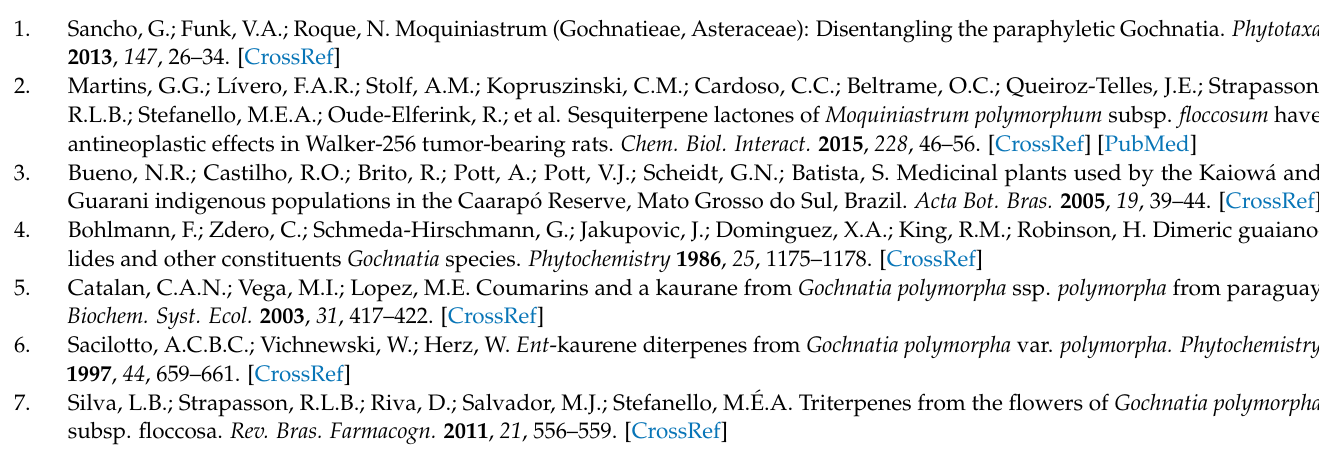
Figure S2: Feature-based molecular network of the 18 extracts from OSMAC approach. Each cluster is formed by interconnected group of nodes (colored circles). Figure S3: Calibration curve of griseo- fulvin obtained from HPLC analysis. Figure S4: Calibration curve of 7-dechlorogriseofulvin obtained from HPLC analysis. Table S1: 1 H NMR data of griseofulvin and 7-dechlorogriseofulvin. Table